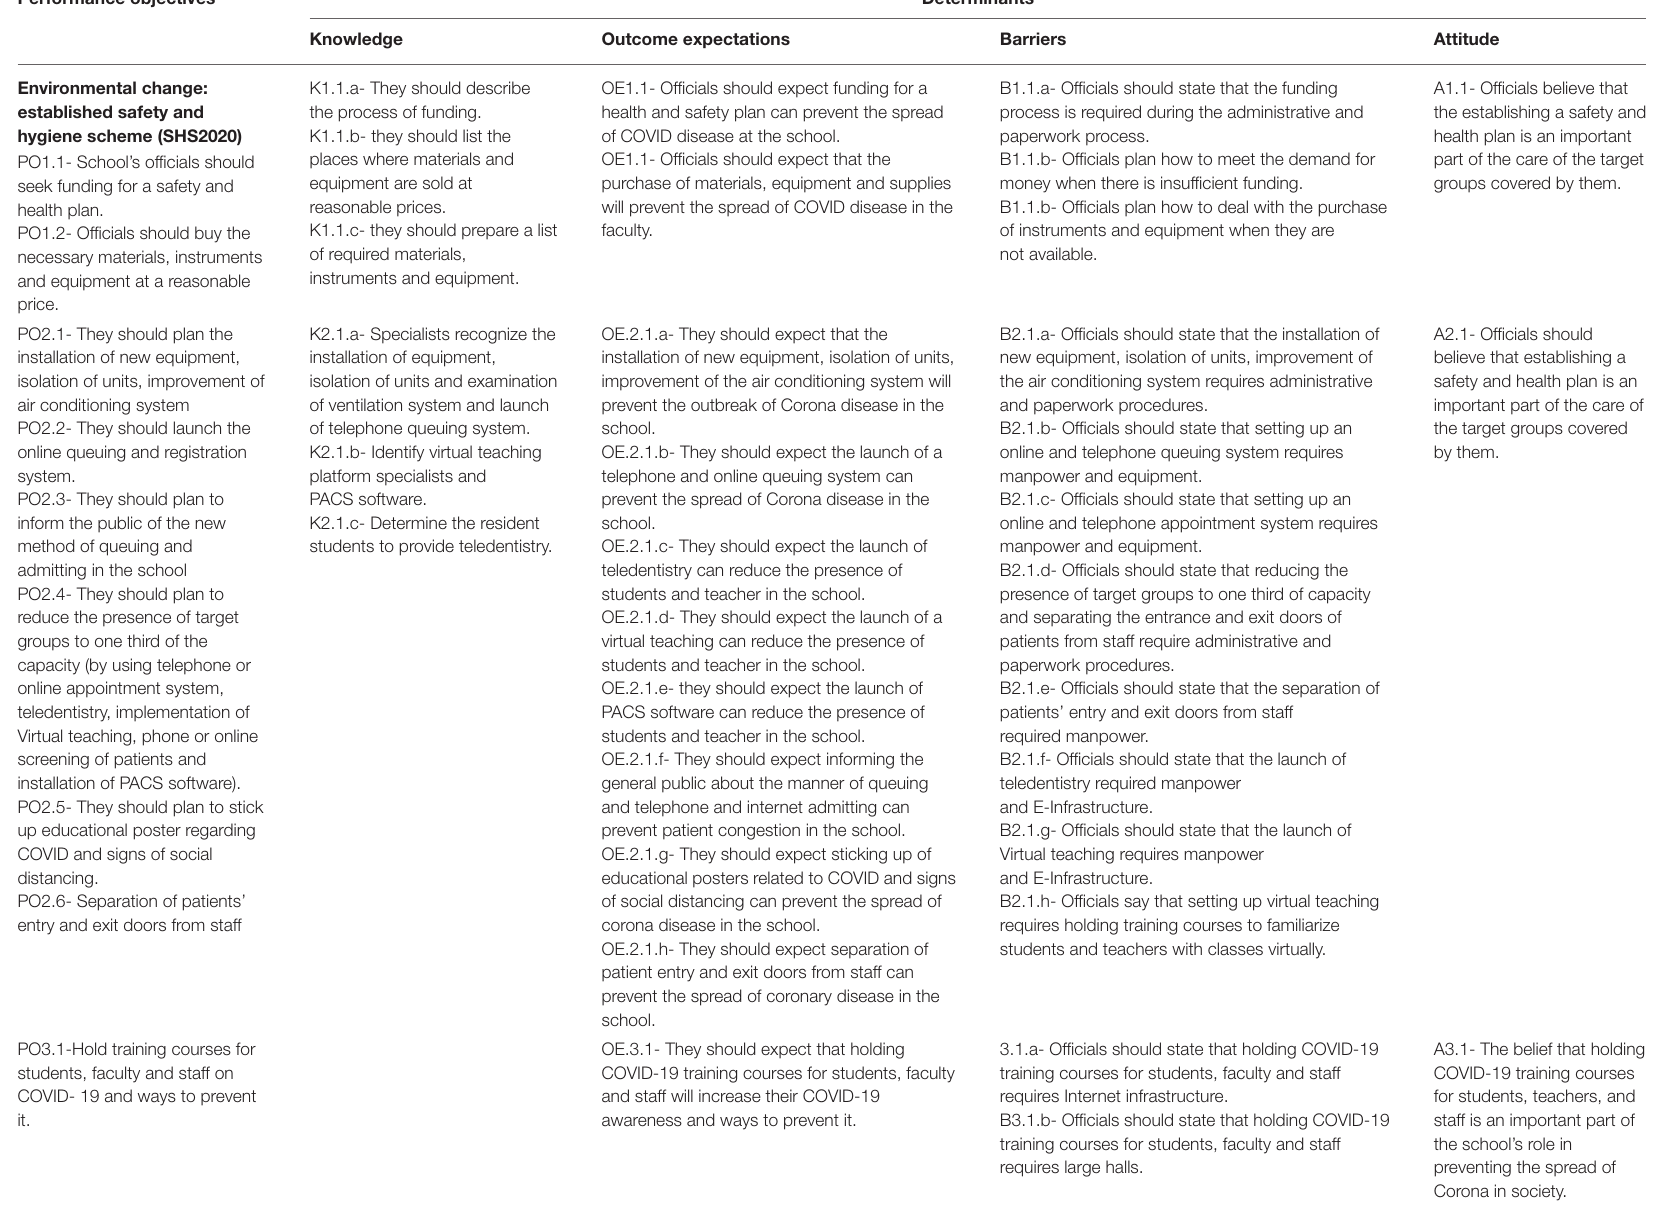
TABLE 3 | The matrix of change objectives for providers. Performance